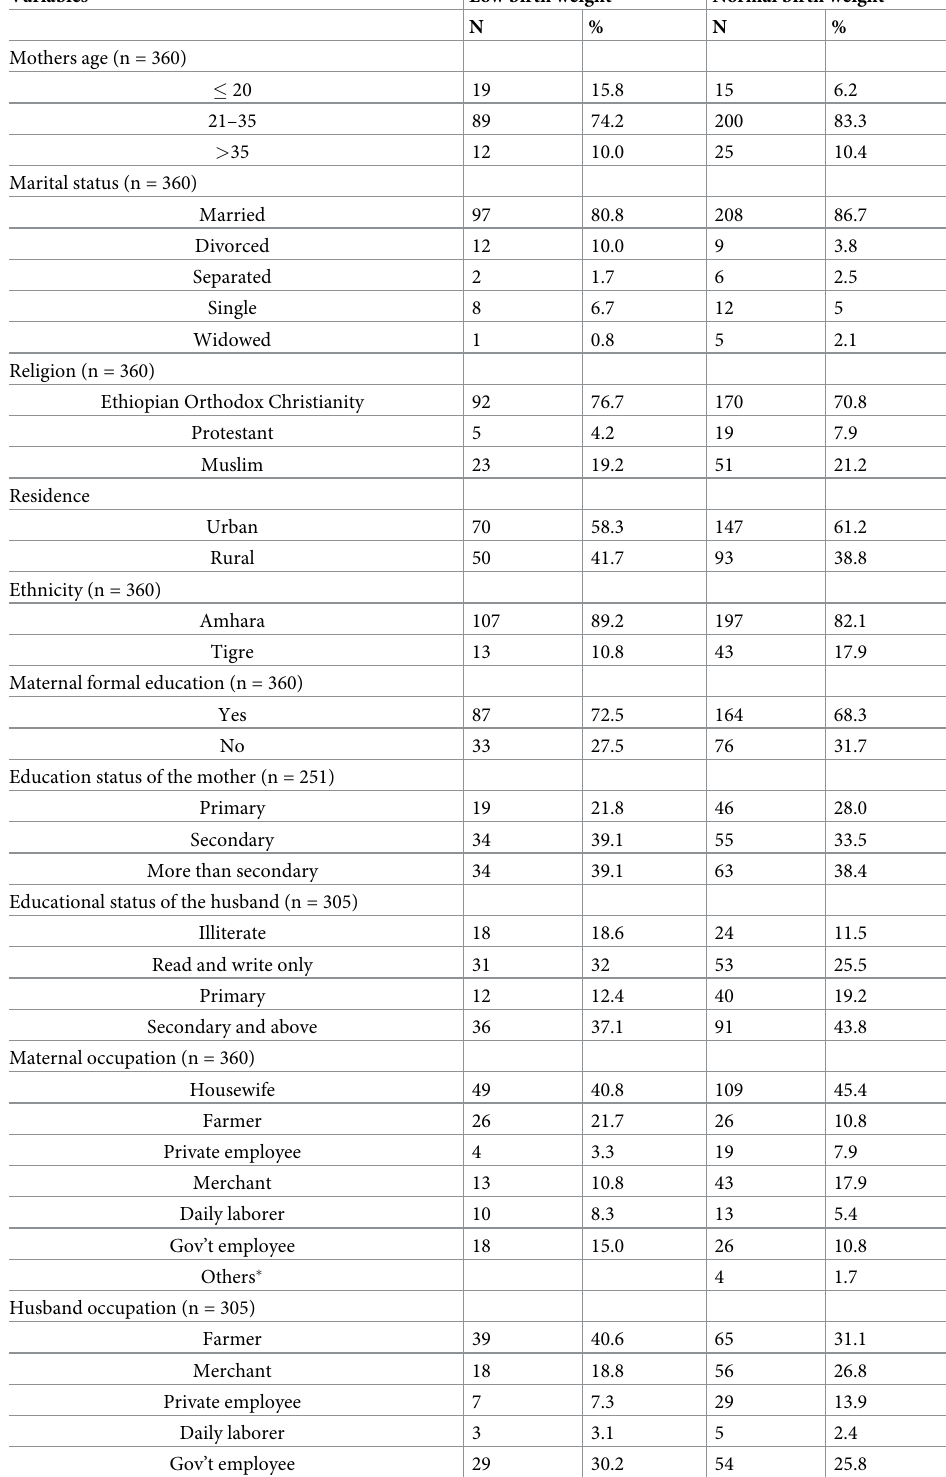
Table 1. Socio-demographic characteristics of mothers in North Wello zone Hospitals, Ethiopia, December